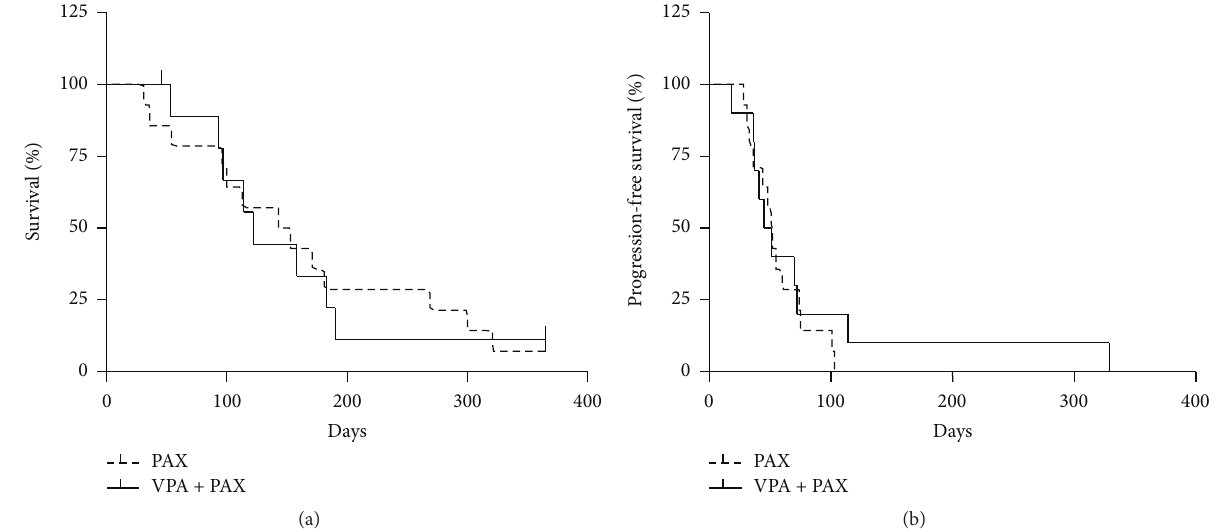
Figure 1: Kaplan-Meier plots of overall survival (a) and progression-free survival (PFS, (b)) of patients with anaplastic thyroid cancer treated with VPA + TAX (-) versus TAX